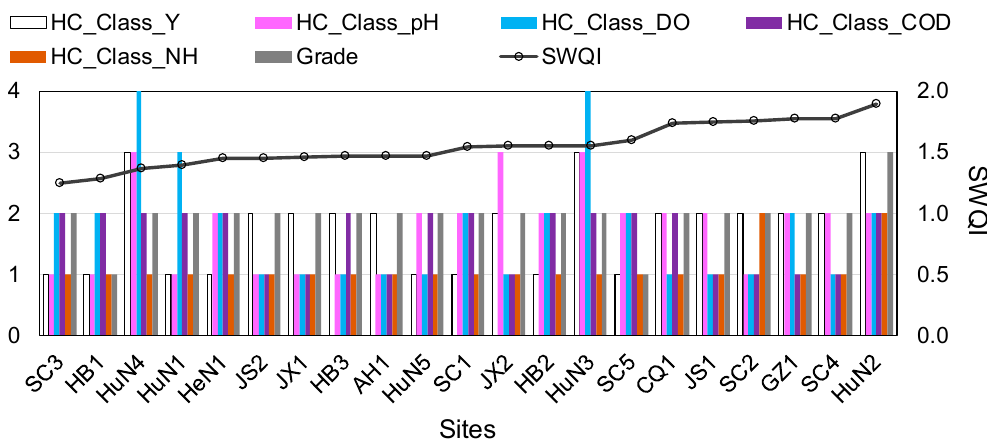
Figure 8. Classifications for five HC clustering algorithms, based on the yearly (for HC_Class_Y) or weekly means (for the other HC models) of the four monitoring indicators, water quality grades, and SWQIs of the 21 YRB sites for 2016. Note: HC_Class_pH represents HC clusters using weekly pH data; HC_Class_DO represents HC clusters using weekly DO data; HC_Class_COD represents HC clusters using weekly COD Mn data; and HC_Class_NH represents HC clusters using weekly NH 3 –N data.